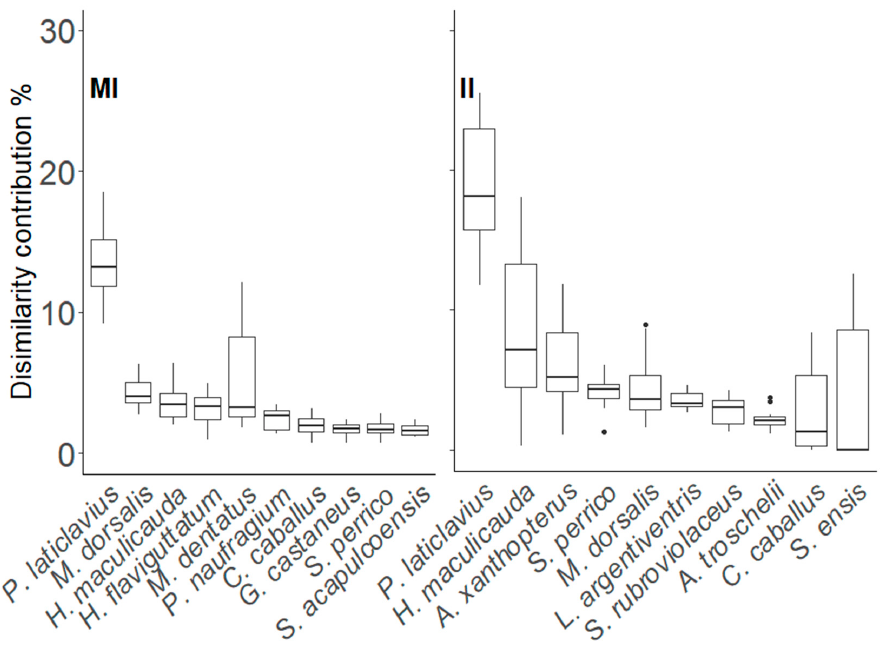
Figure 5. Average dissimilarity contribution (SIMPER analysis) between years from the most con- spicuous species of Marietas Islands (MI) and Isabel Island (II).